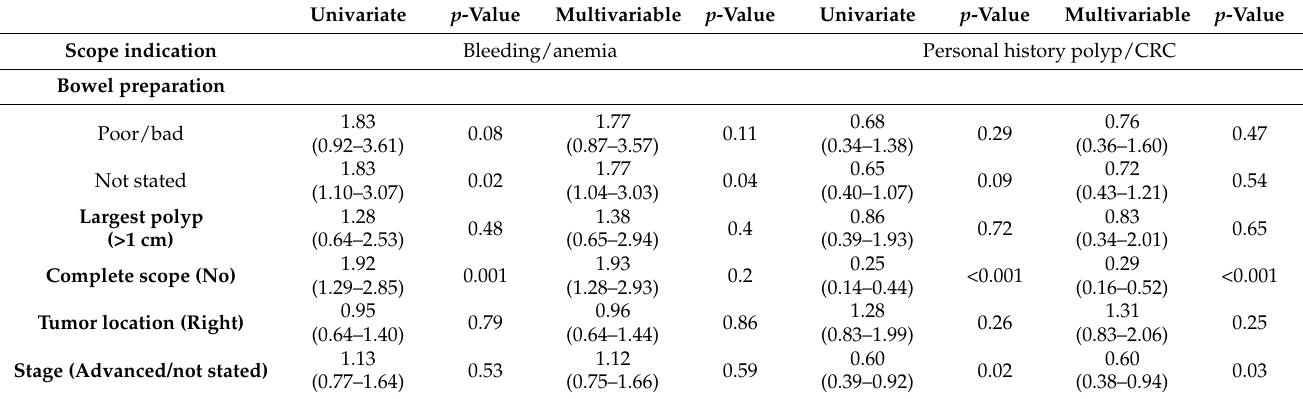
Table 4. Derived univariate and multivariable odds ratios for a colonoscopy by indication. Univariate p -Value Multivariable p -Value Univariate p -Value Multivariable p